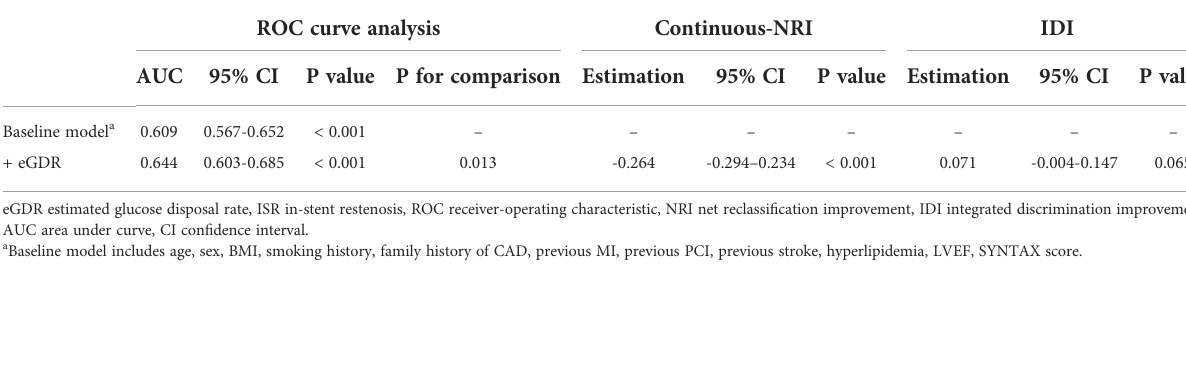
TABLE 3 Incremental effect of eGDR on ISR prediction by existing risk model in general